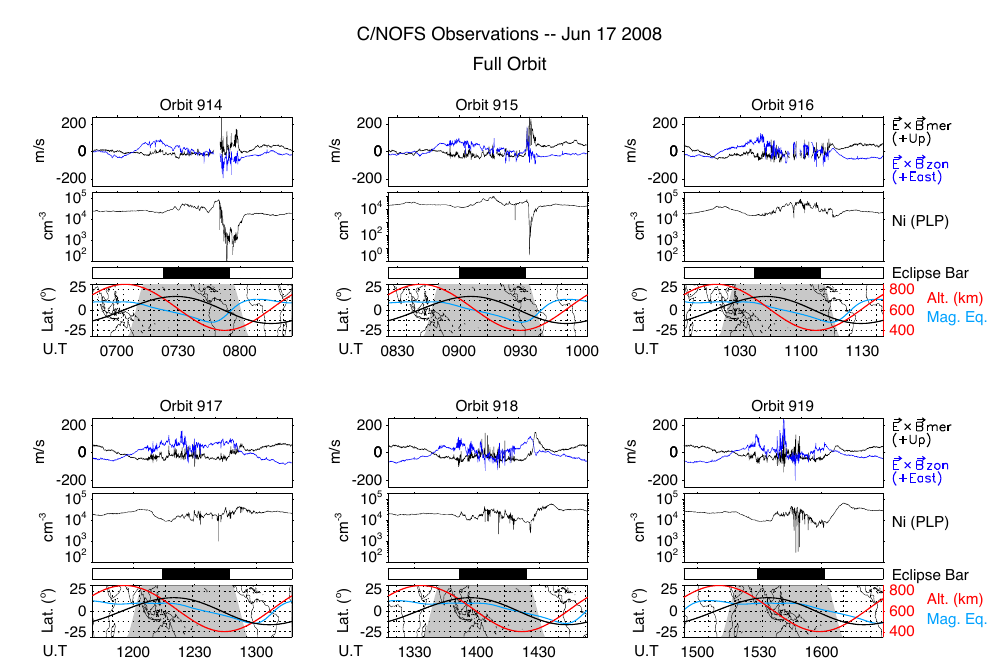
Figure 2. Meridional and zonal plasma drifts measured by VEFI and ion density measured by PLP for six consecutive orbits of the C/NOFS satellite on 17 June 2008. The eclipse bar below the middle panel shows when the satellite was in the Earth’s shadow. The lowest panel shows the C/NOFS geographic location and altitude, the magnetic equator, and the Earth’s shadow on the ground.